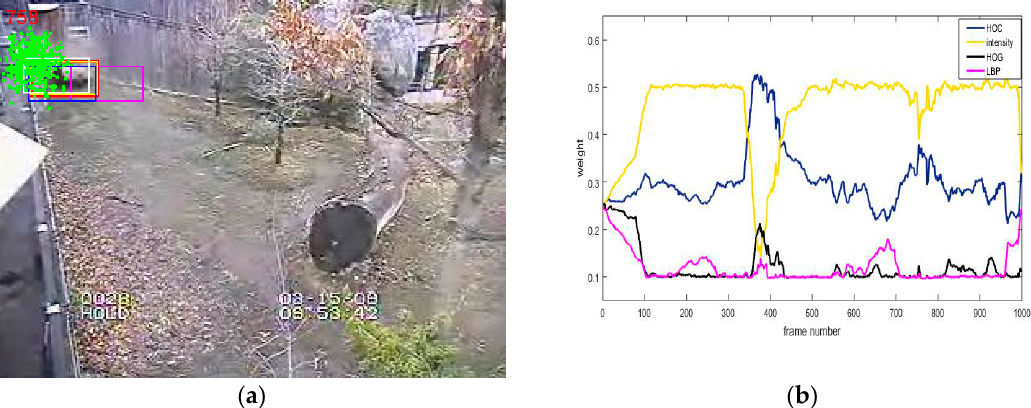
Figure 3. In ( a ), the red bounding box represents the final target state, the blue one represents the most similar particle to the target template for the histogram of color (HOC) feature, the yellow one represents the most similar particle to the target template for the intensity feature, the white one represents the most similar particle to the target template for the histogram of oriented gradient (HOG) feature, and the purple one represents the most similar particle to the target template for the LBP feature; ( b ) Is the variation curve of the weights of different features during the tracking of the Panda sequence (in this paper, we set the upper and lower limits of the weight, with a maximum of 0.5 and a minimum of 0.1).